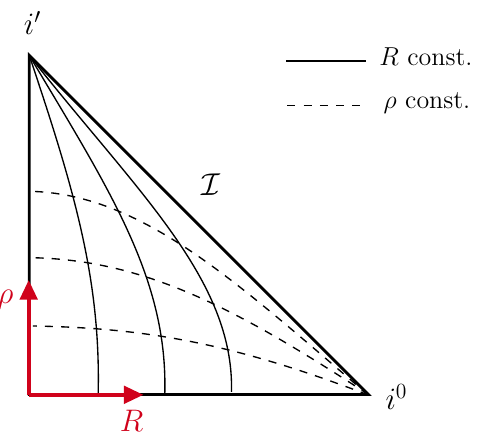
Figure 1. The toric Penrose diagram for flat Klein space [16]. Null lines are at 45 ◦ , and lines of constant ρ and R are shown. Timelike ( i 0 ), spacelike ( i 0 ) and null infinity ( I ) are also